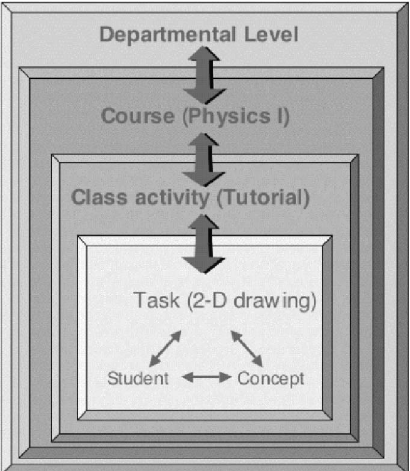
FIG. 5. Frames of Context: a particular task is embedded in a larger situation (cid:1) a tutorial class activity (cid:2) , which is embedded in a larger microculture (cid:1) a particular class (cid:2) , and so